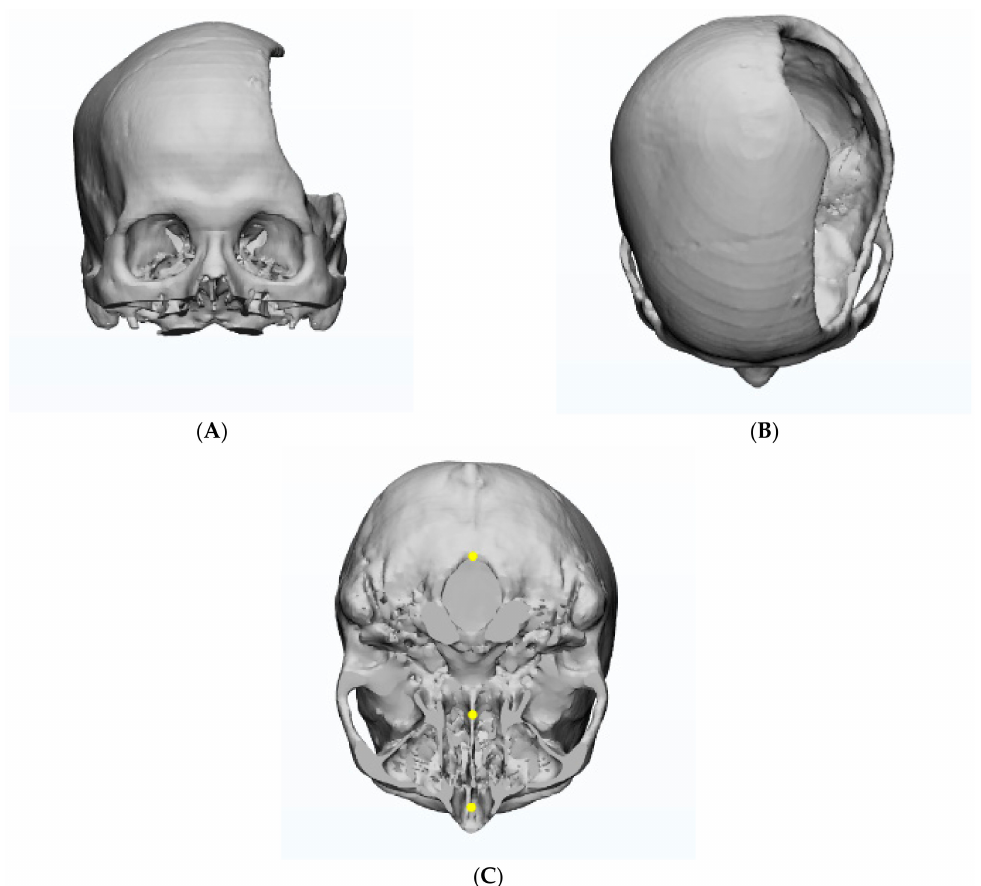
Figure 1. Unilateral defect skull model ( A ). front view ( B ). top view ( C ). bottom view with three reference points; Nasion, PNS,